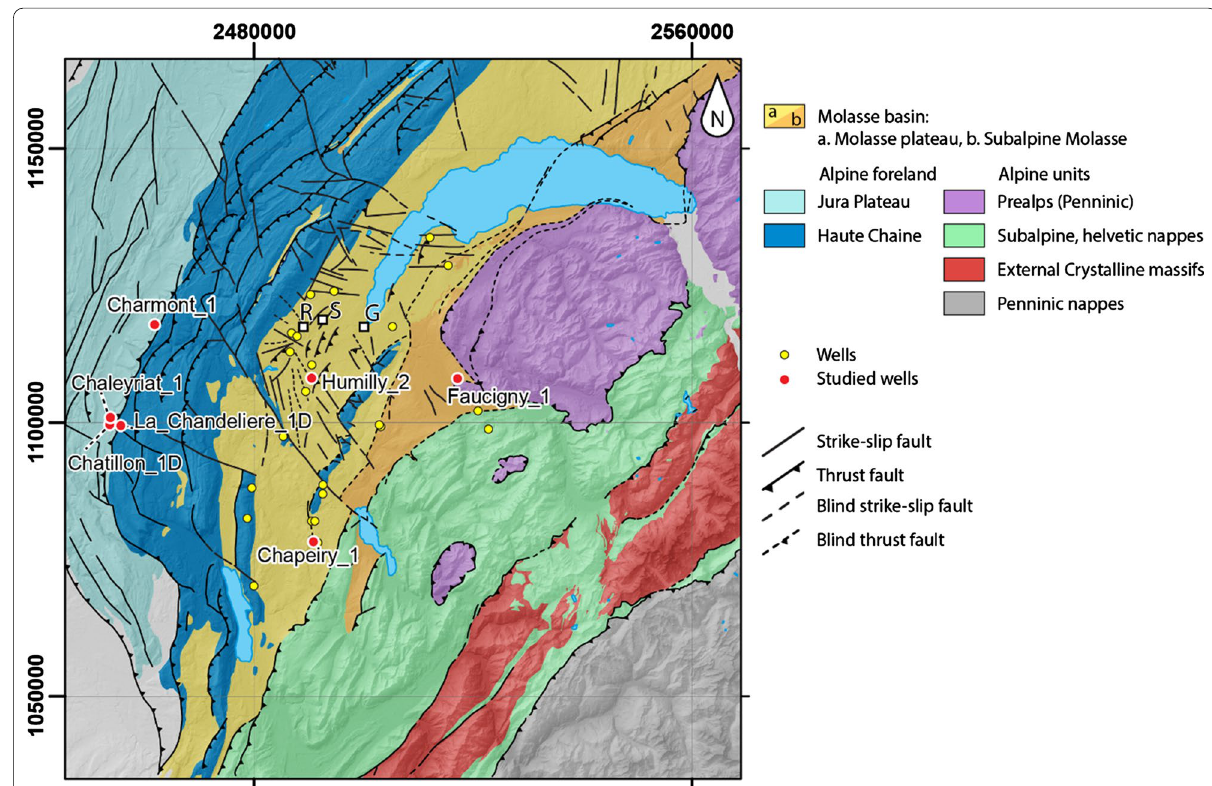
Fig. 1 Geological map of the southwestern Molasse Basin and location of the studied area. Red dots are the deep wells studied. Yellow dots are the other deep wells used to constrain the geological model GeoMol (https ://genev e.geomo l.ch). G Geneva, S Satigny, R Roulave